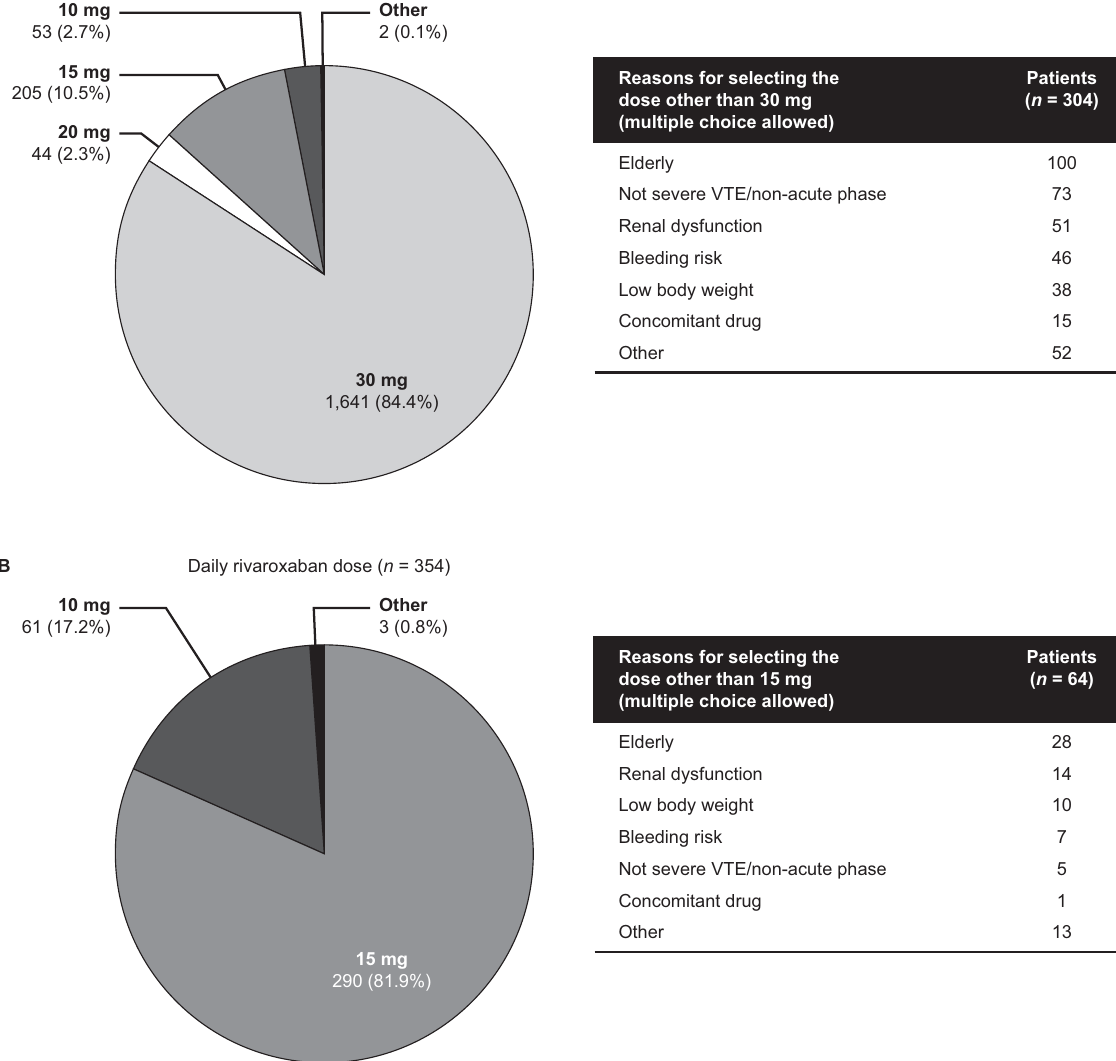
Fig. 3 Rivaroxaban doses selected for (A) initial treatment and (B) maintenance treatment in XASSENT participants, with reasons for selecting non-recommended dose (i.e., a dose other than the approved dose). Data are presented as n (%) or as n . VTE, venous thromboembolism. Note: The reasons for the dose selection described by attending physicians were categorized and tabulated. Bleeding risk was a judgement by attending physicians. Reasons for a patient who received 15mg in the initial treatment group are